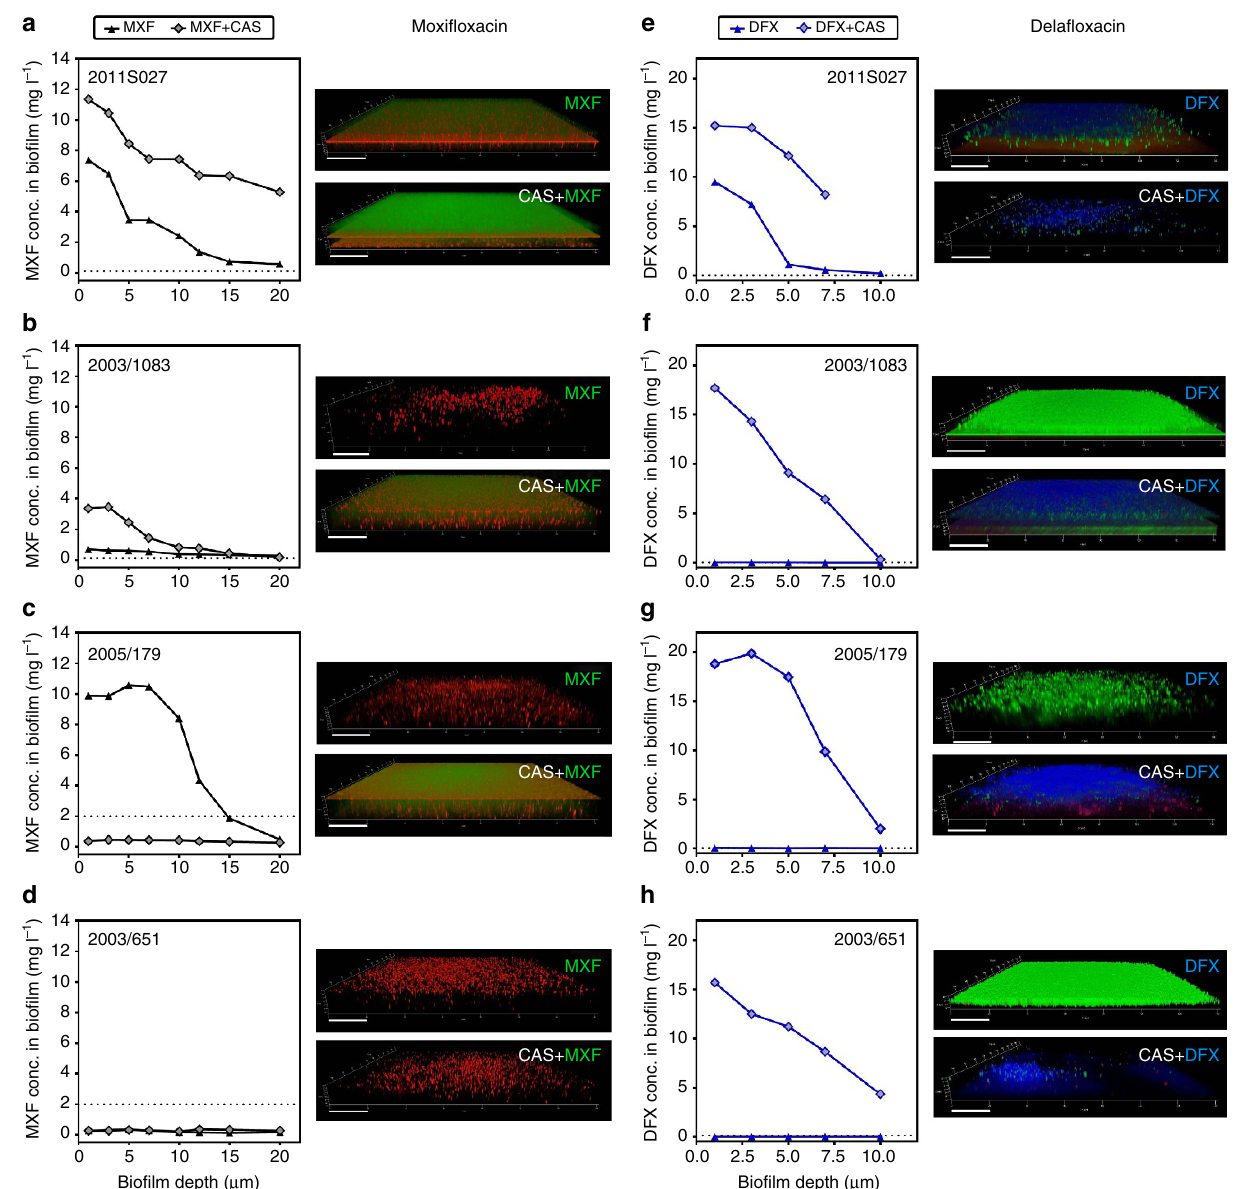
Figure 7 | Effect of caspofungin on fluoroquinolone penetration within biofilms. ( a–d ) Moxifloxacin (MXF); ( e–h ) delafloxacin (DFX). The graphs compare the concentration of fluoroquinolone in biofilms incubated with 20mgl (cid:2) 1 of fluoroquinolone alone (MXF or DFX) or combined with 40mgl (cid:2) 1 caspofungin (MXF þ CAS or DFX þ CAS). The horizontal dotted line corresponds to the fluoroquinolone MIC for the corresponding strain. The tridimensional images were obtained using confocal laser scanning microscopy for the corresponding biofilms stained either with 0.5mM of 5-cyano-2,3-ditolyl tetrazolium chloride (red signal: MXF experiment) or with LIVE/DEAD (green signal: living bacteria; red: dead bacteria). The moxifloxacin fluorescence signal appears as green (preventing us from using LIVE/DEAD staining of the corresponding biofilm) and the delafloxacin signal, in blue. Scale bars, 20 m